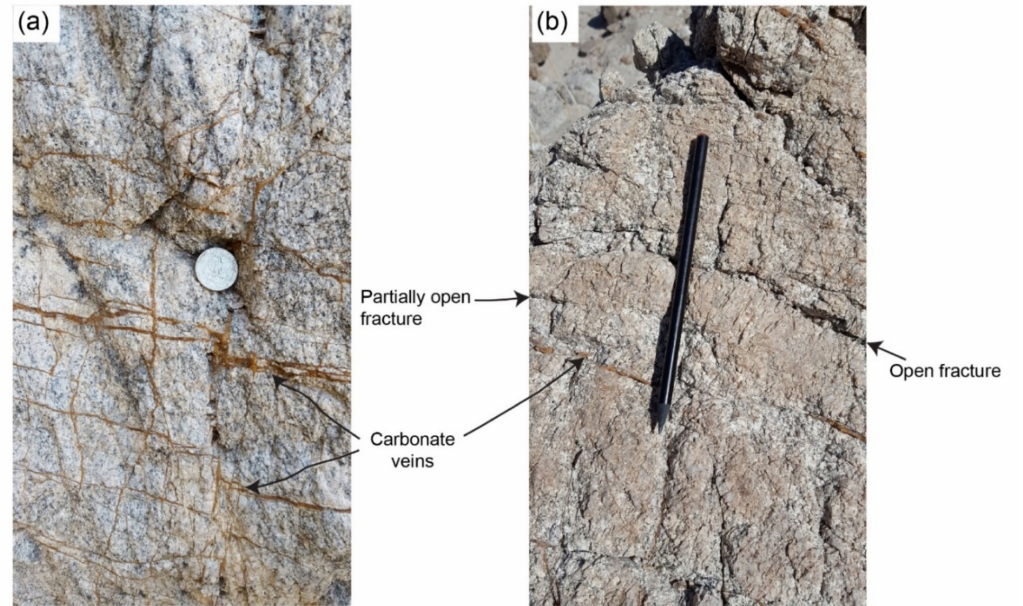
Figure 12. Illustration of the observed fractures observed in the field, mostly affected by mineralization. ( a ) Picture taken near OT6 illustrating veins fully sealed by carbonates. ( b ) Picture taken near the Canadian Wash illustrating open and partially open fractures. The carbonates are ubiquitous following SDVFZ trend (i.e., NW/SE). The fractures striking E/W have been observed with a wider aperture and were filled by barite and